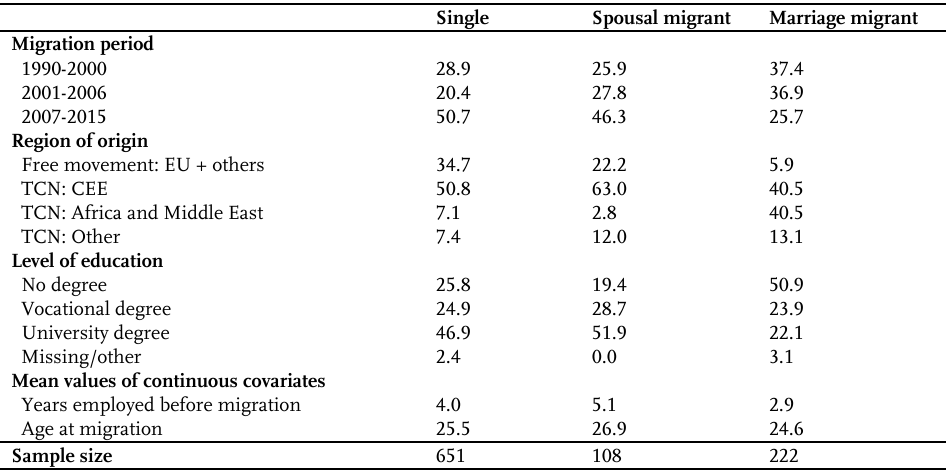
Table 1 : Descriptive statistics of time-constant covariates by migration group, column % Single Spousal migrant Marriage